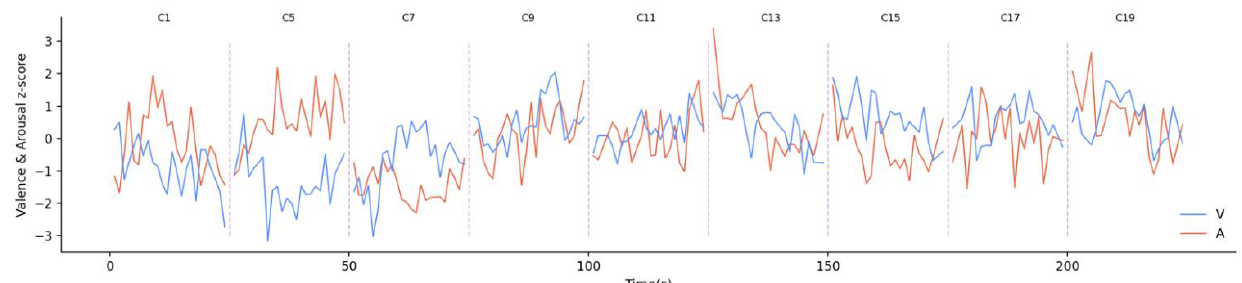
Figure 6. Real-time changes of emotional perception data.